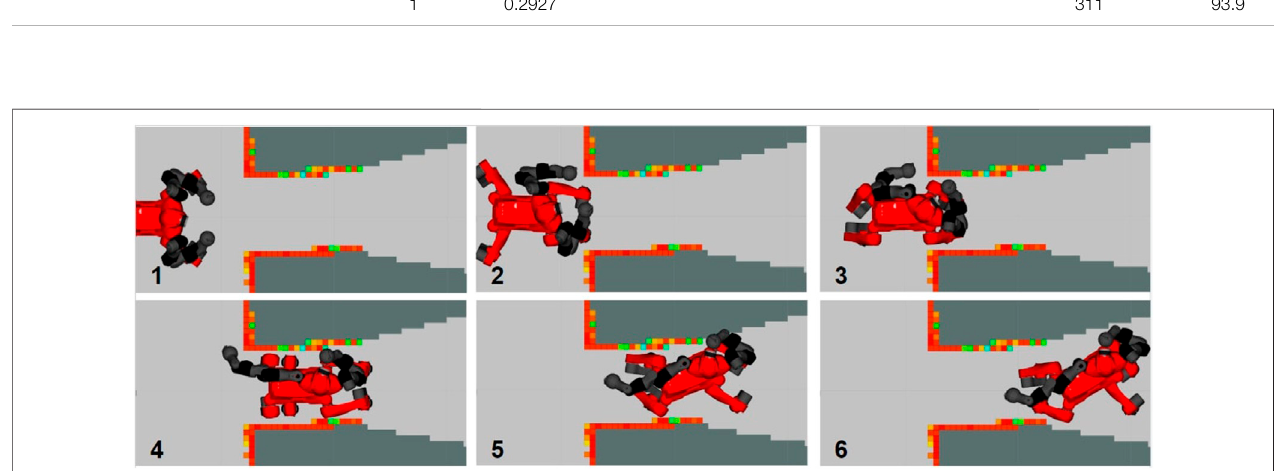
FIGURE 7 | Screenshots of CENTAURO passing through the high narrow corridor.